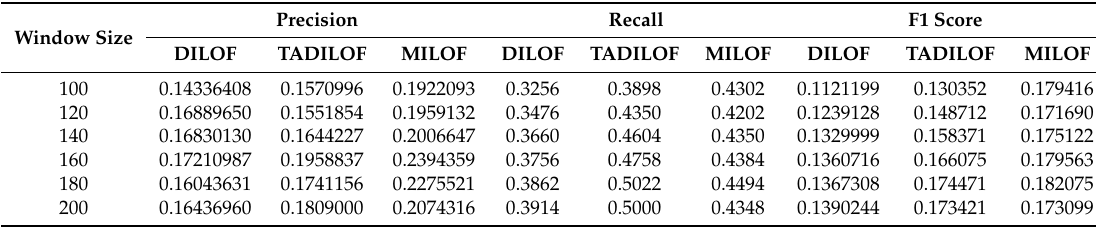
Table 10. Precision, recall, and F1 score on Vowels